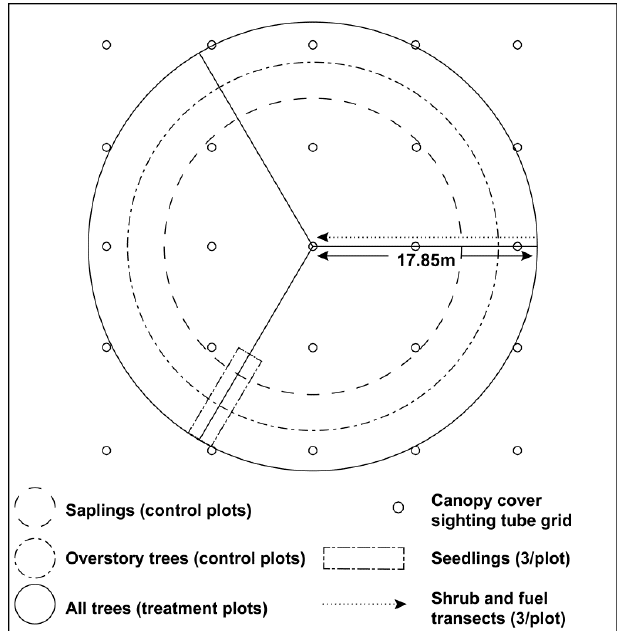
Figure 2. Illustration of sampling plot layout. Three sampling plots were placed in each treatment site to investigate patterns of fuel, vegetation, and stand development after treatment. Sampling did not vary between control and treatment sites with the exception of tree data